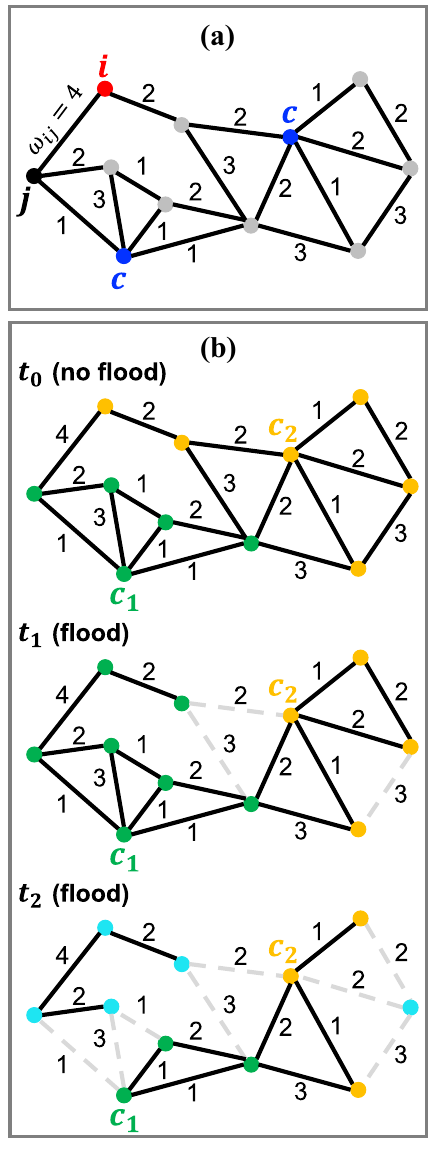
Figure 3. Temporal evolution of towns during a flood event. ( a ) Part of a weighted road network, illustrating a typical network’s i -node and two c -nodes, which represent two town centers. Single-road lengths d roads and single-road travel times τ roads were used as network weights. ( b , top): Definition of towns, i.e. assignment of the road network’s nodes to the nearest town centers at t 0 . In ( b , middle), all nodes “tend to reach” the closest town centers, even if different from their initially assigned ones at time t 0 . That means that the two nodes at the top left corner, which were yellow at t 0 , become green at t 1 , since now closer to the town center c 1 . As consequence, the towns’ sizes change over time. In ( b , bottom) further flood advancement wipes out other roads, isolating a number of nodes (as singlets or small clusters) from their closest town centers. In this example, at time t 0 , the size of the two towns would be | K 1 ( t 0 ) | = 5 , | K 2 ( t 0 ) | = 6 . At time t 1 , we would count | K 1 ( t 1 ) | = 7 , | K 2 ( t 1 ) | = 4 , while at time t 2 , we would have | K 1 ( t 2 ) | = 3 , | K 2 ( t 2 ) | = 3 , and a total number of disconnected nodes equal to N ∞ ( t 2 ) = 5 . This figure was produced with PowerPoint 58